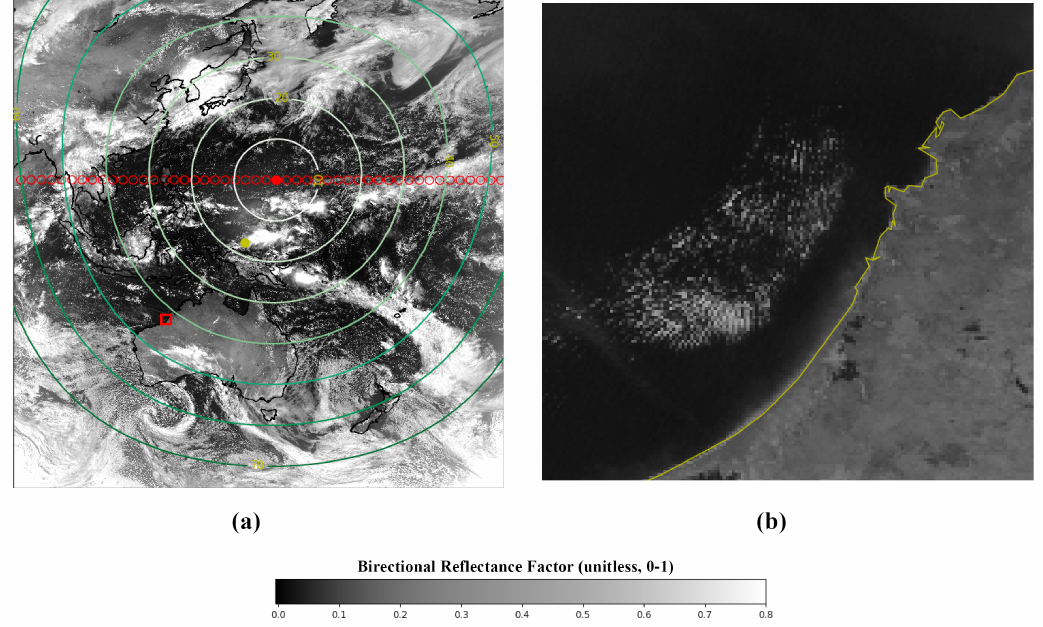
Figure 10. Same as Figure 9, but for Himawari-8 AHI (Band 3, 0.64 µ m) on 2 May 2018, 02:00 UTC. The trace of the solar subpoints (red circles) is calculated at 10 min time steps. The area marked by the red rectangle in Panel ( a ) and enlarged in Panel ( b ) is near the La Grange Bay of Western